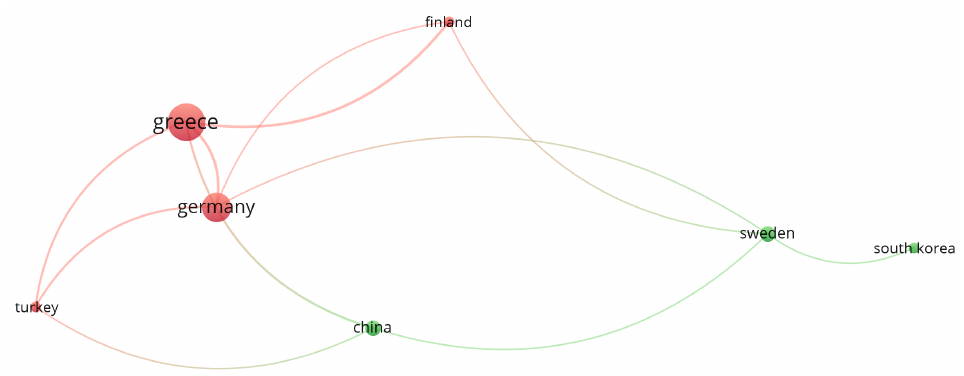
Figure 12. Country citation correlation between the selected